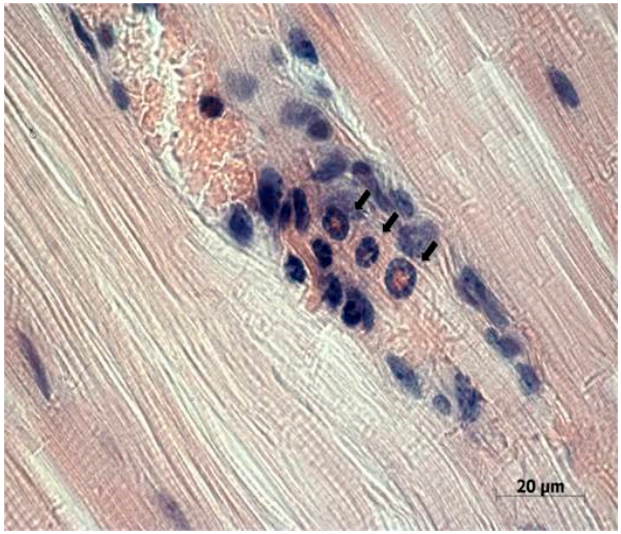
Figure 5. Neutrophils, lymphocytes, and macrophages (denoted by arrows) in the muscle tissue adjacent to the Krebs-2 tumor node in a mouse receiving a serious of NDV/Altai/pigeon/770/2011 strain injections and with a significant tumor reduction in MRI. Day 20 after virotherapy (day 28 of tumor growth), hematoxylin-eosin staining.